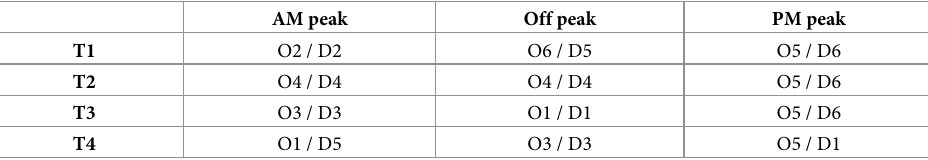
Table 3. Major origin-destination pairs of all trip patterns in three different peak